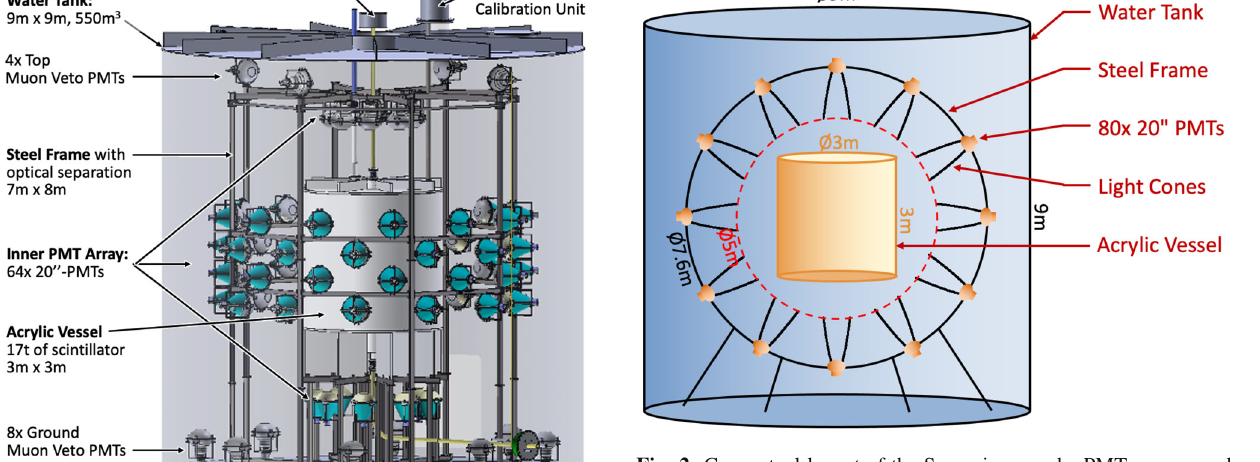
Fig. 2 Conceptual layout of the Serappis upgrade. PMTs are moved further from the Acrylic Vessel and equipped with light